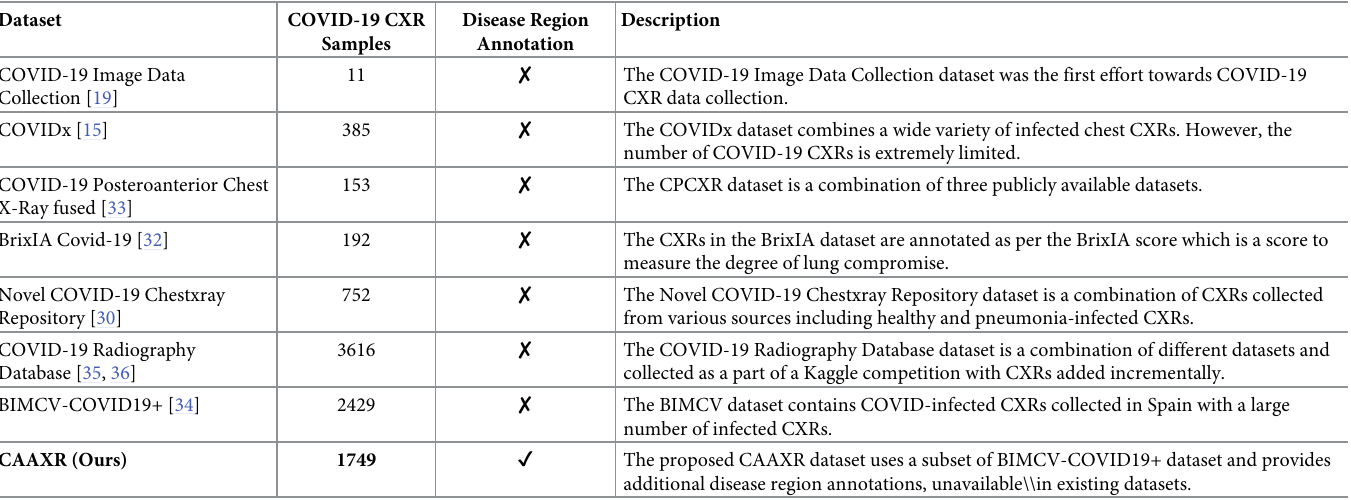
Table 1. Summary of existing datasets containing COVID-19 positive chest